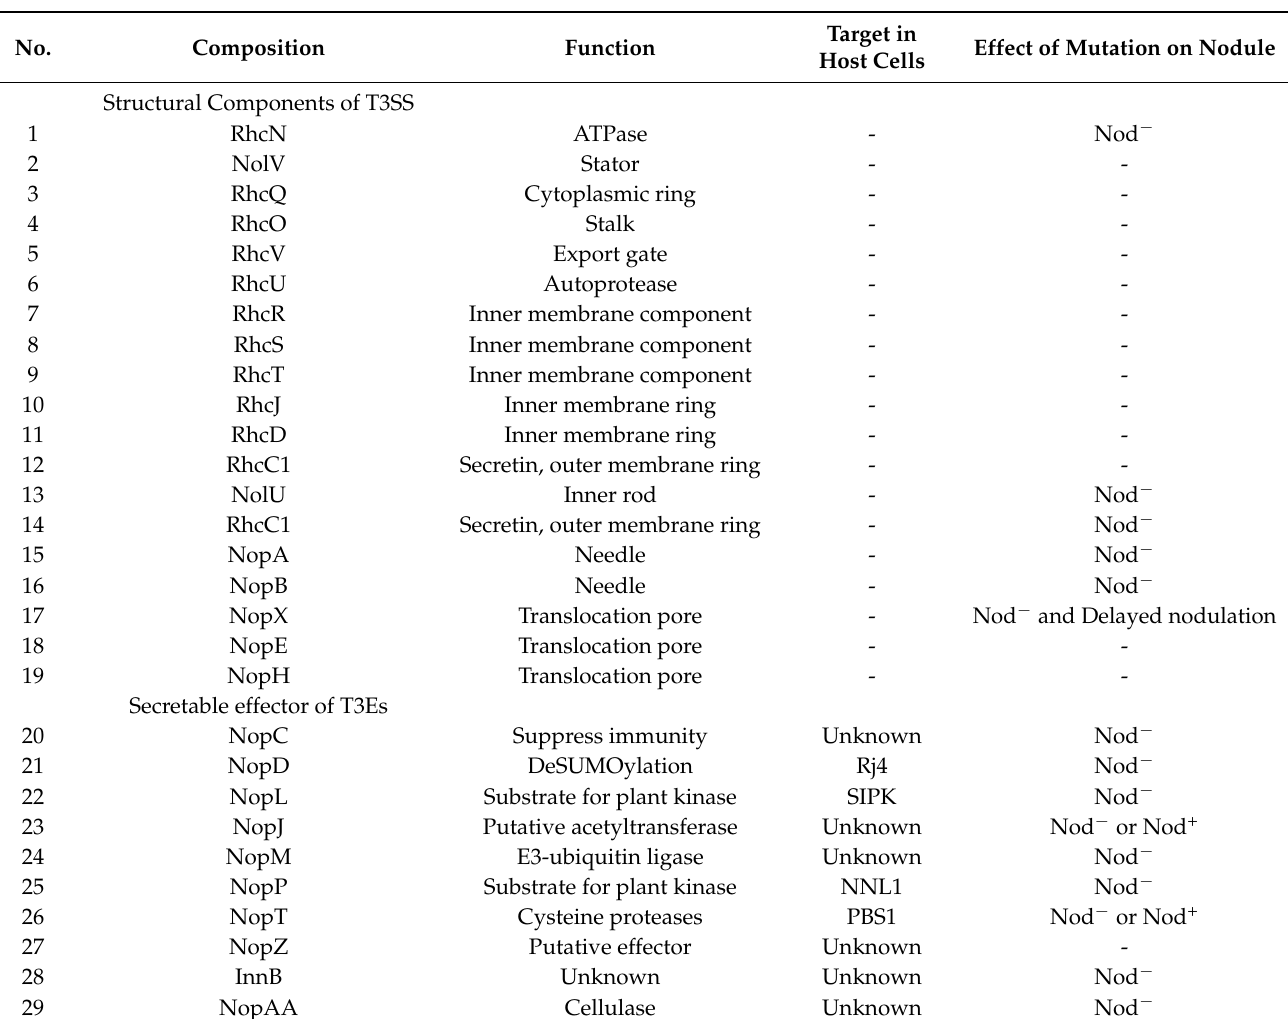
Table 1. Core structural components and functions of T3SSs and T3Es in